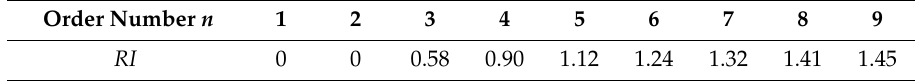
Table 4. Values of mean random consistency index ( RI